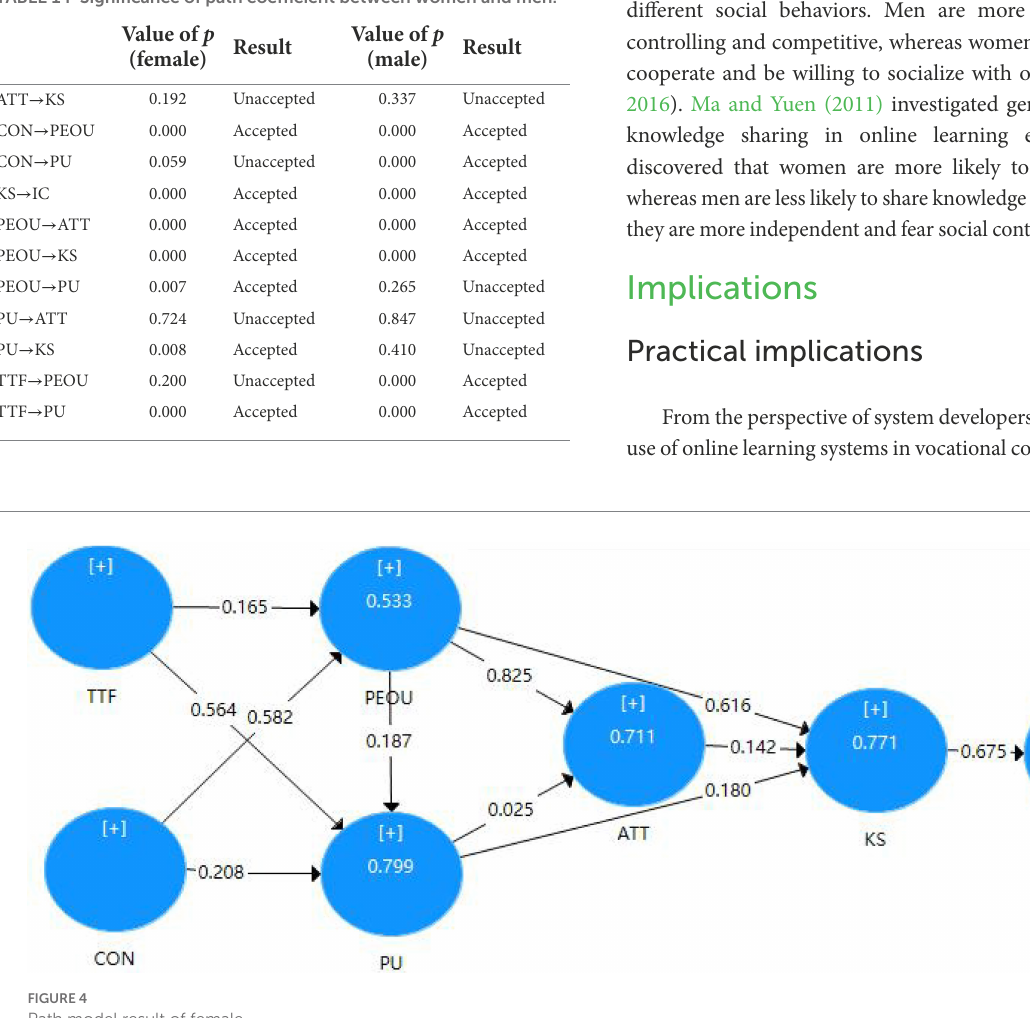
TABLE 14 Significance of path coefficient between women and men.